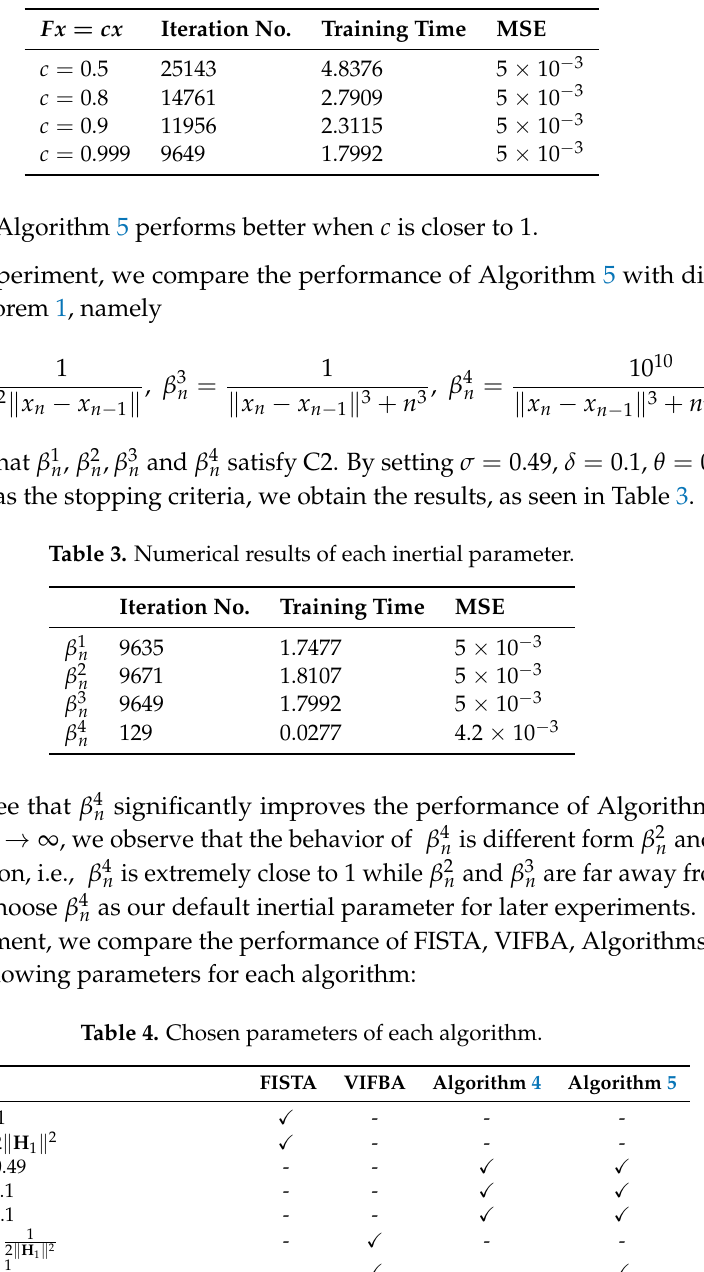
Table 2. Numerical results of c -contractive mapping.